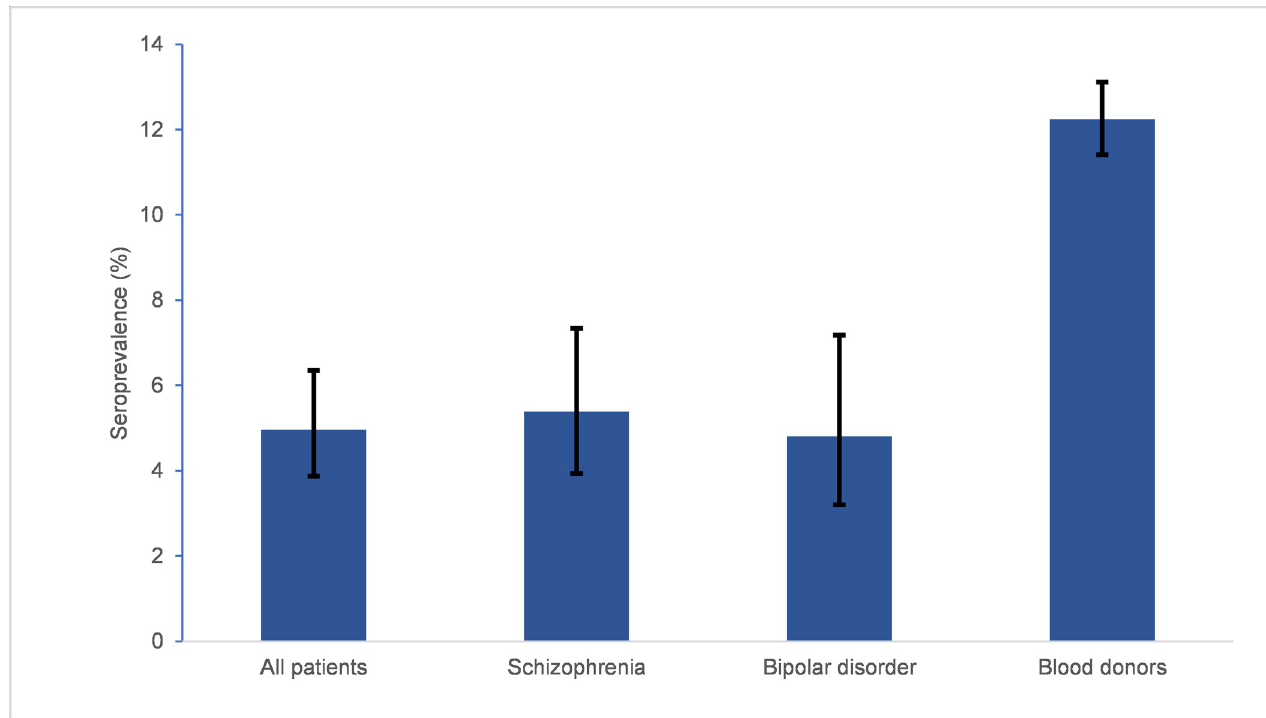
Fig 2. Seroprevalences for included patients with severe mental illness compared with blood donors of the Capital Region of Denmark. Seroprevalences adjusted for test sensitivity and specificity with 95% confidence intervals among all included patients with severe mental illness (n = 1258), according to ICD-10 diagnosis (schizophrenia n = 725, bipolar disorder n = 484) and blood donors (n = 6088).